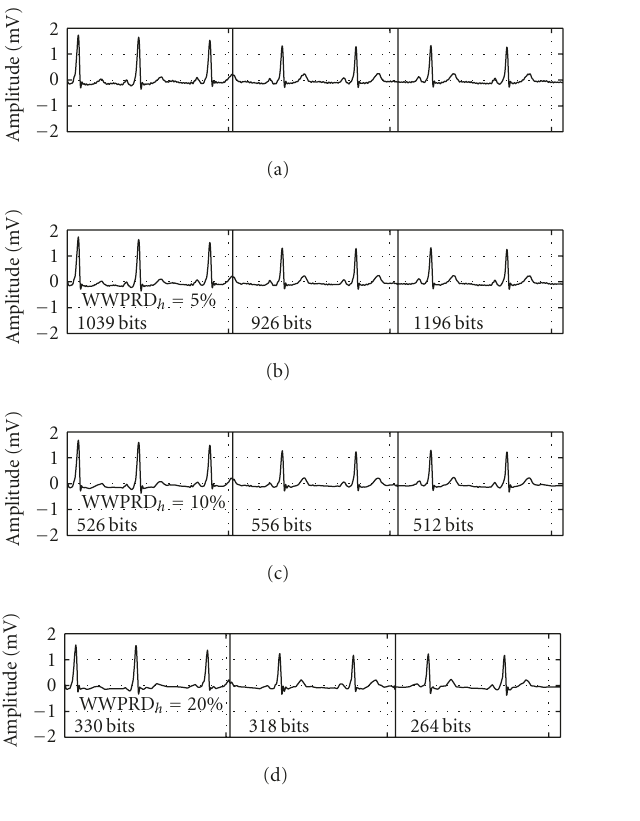
Figure 6: Original signal. (b) Reconstructed signal when guaran- teeing WWPRD w = 5%. (c) Reconstructed signal when guarantee- ing WWPRD w = 10%. (d) Reconstructed signal when guaranteeing WWPRD w =